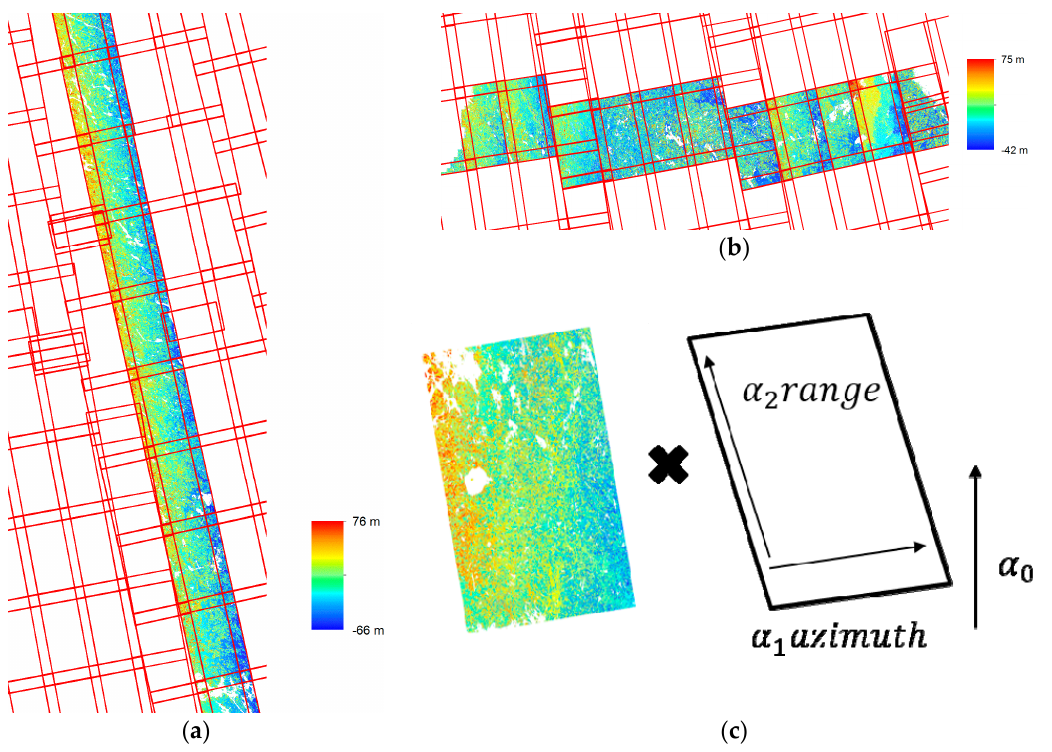
Figure 9. Illustration of the phase trend appearance in images with merely the unwrapped phase for ( a ) an along track orbit and ( b ) acquisitions from several track orbits. ( c ) Illustration of how a single scene was multiplied with a correction raster, based on the coefficients α 0,1,2 .